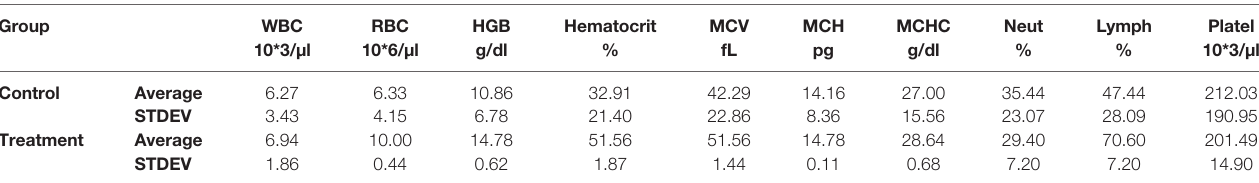
Group WBC RBC HGB